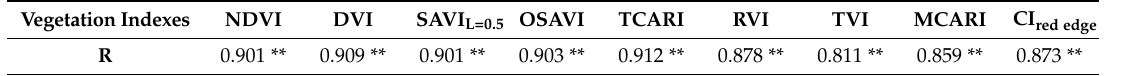
Table 4. Correlation between UAV-based vegetation indexes and SPAD values.